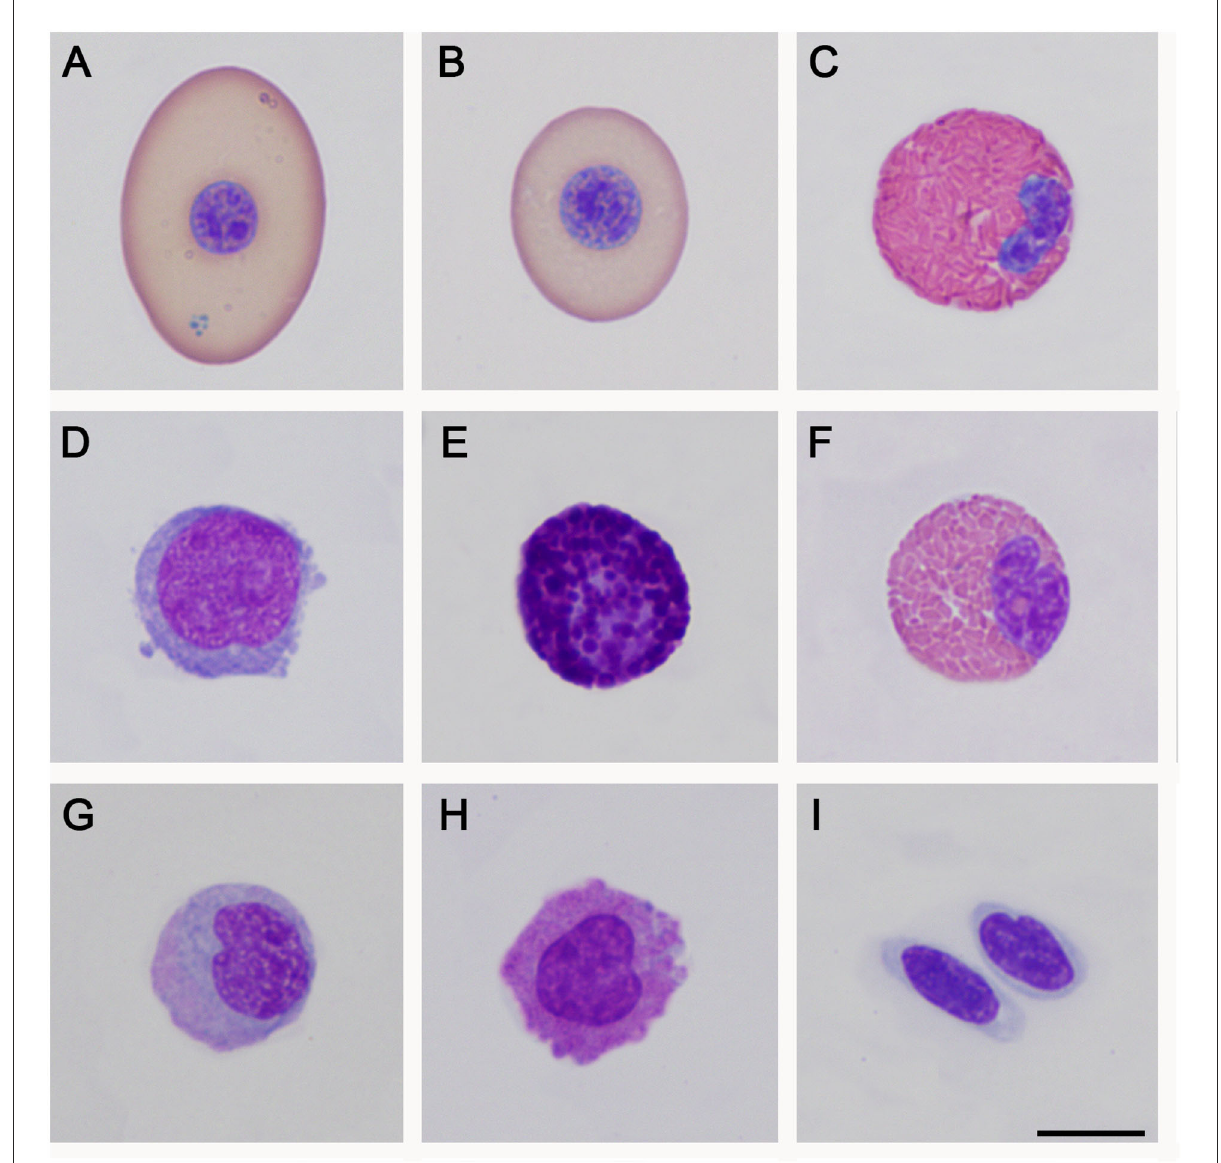
FIGURE2 Peripheral blood cells of Podocnemis unifilis . (A) : Mature erythrocyte; (B) : Polycromatophil; (C) : Heterophil; (D) : Mature lymphocyte; (E) : Basophil; (F) : Eosinophil; (G) : Monocyte; (H) : Azurophil-like; (I) : Thrombocyte. Wright staining. Bar: 10 µ m.